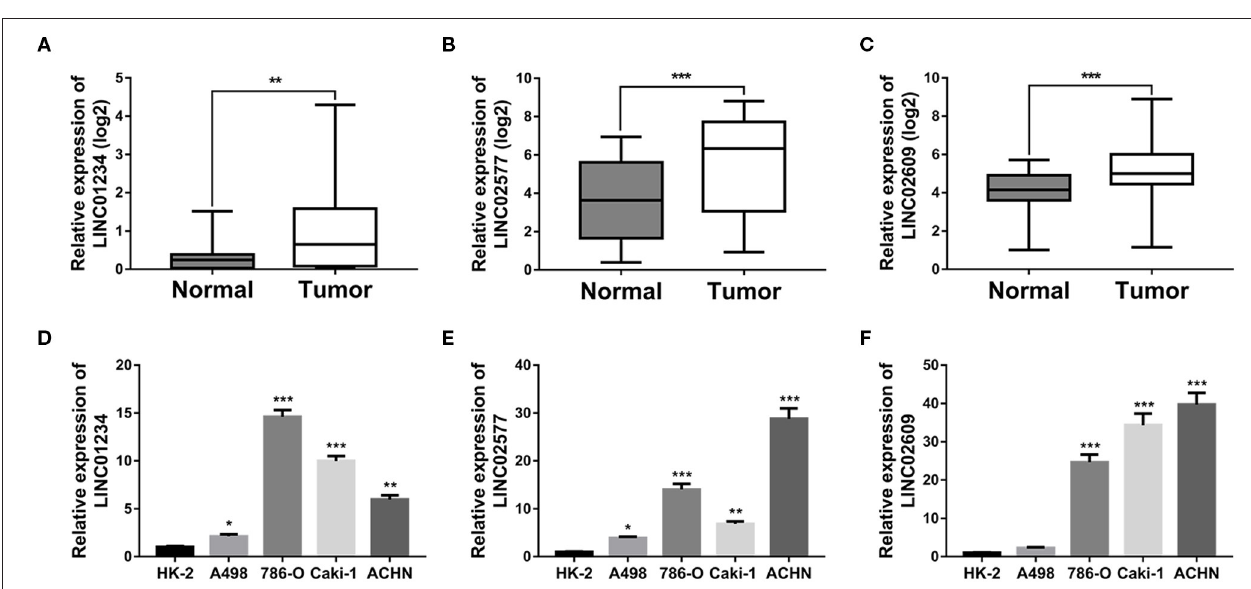
FIGURE 11 | Quantitative real-time (qRT)-PCR validation of three key lncRNAs. Relative expression levels of LINC01234 (A) , LINC02577 (B) and LINC02609 (C) in 30 matched normal and ccRCC tissues harvested at The First Affiliated Hospital of Anhui Medical University. Relative expression levels of LINC01234 (D) , LINC02577 (E) , and LINC02609 (F) between normal renal tubular epithelial cell line and ccRCC cell lines was determined by qRT-PCR, where * p < 0.05, ** p < 0.01, and *** p < 0.001. lncRNAs, long non-coding RNAs; qRT-PCR, quantitative real-time-PCR.